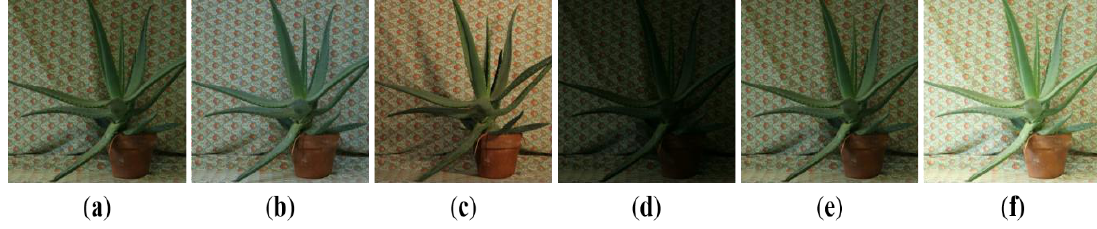
Figure 7. The left image of the aloe data under three different illuminations (with the same exposure 1) and with three different exposure settings (under the same Illumination 1). ( a ) Illumination 1; ( b ) Illumination 2; ( c ) Illumination 3; ( d ) Exposure 0; ( e ) Exposure 1; ( f ) Exposure 2.